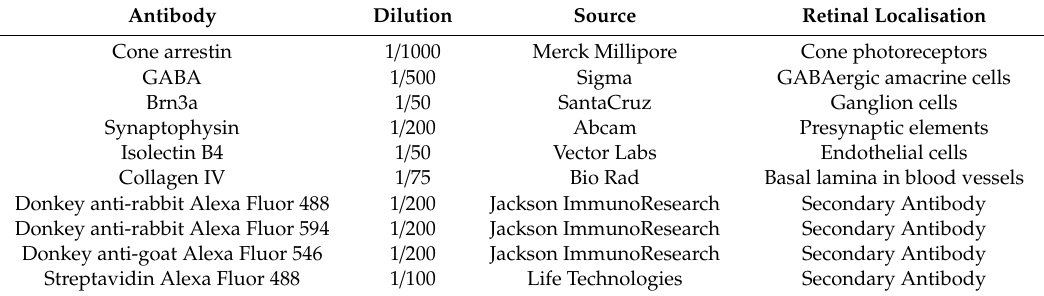
Table 1. Primary Antibodies and Secondary